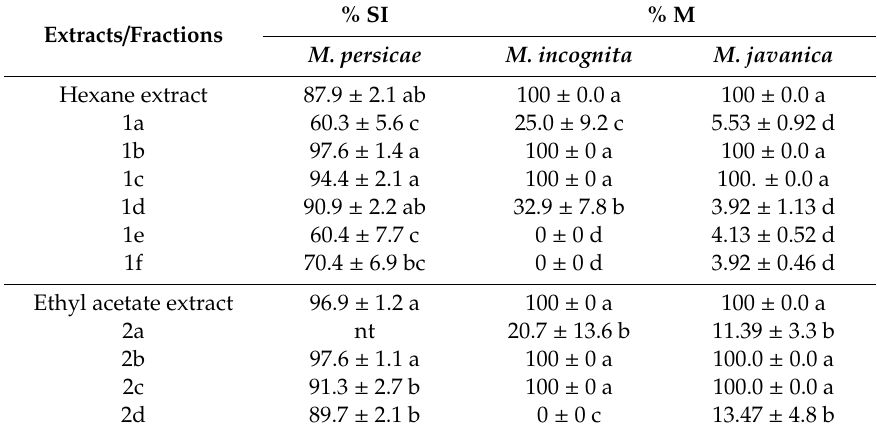
Table 1. E ff ect of extracts and fractions from Eugenia winzerlingii leaves on Myzus persicae (100 µ g / cm 2 ) and on two root-knot nematodes Meloidogyne incognita and Meloidogyne javanica (1 µ g / µ L). Extracts /